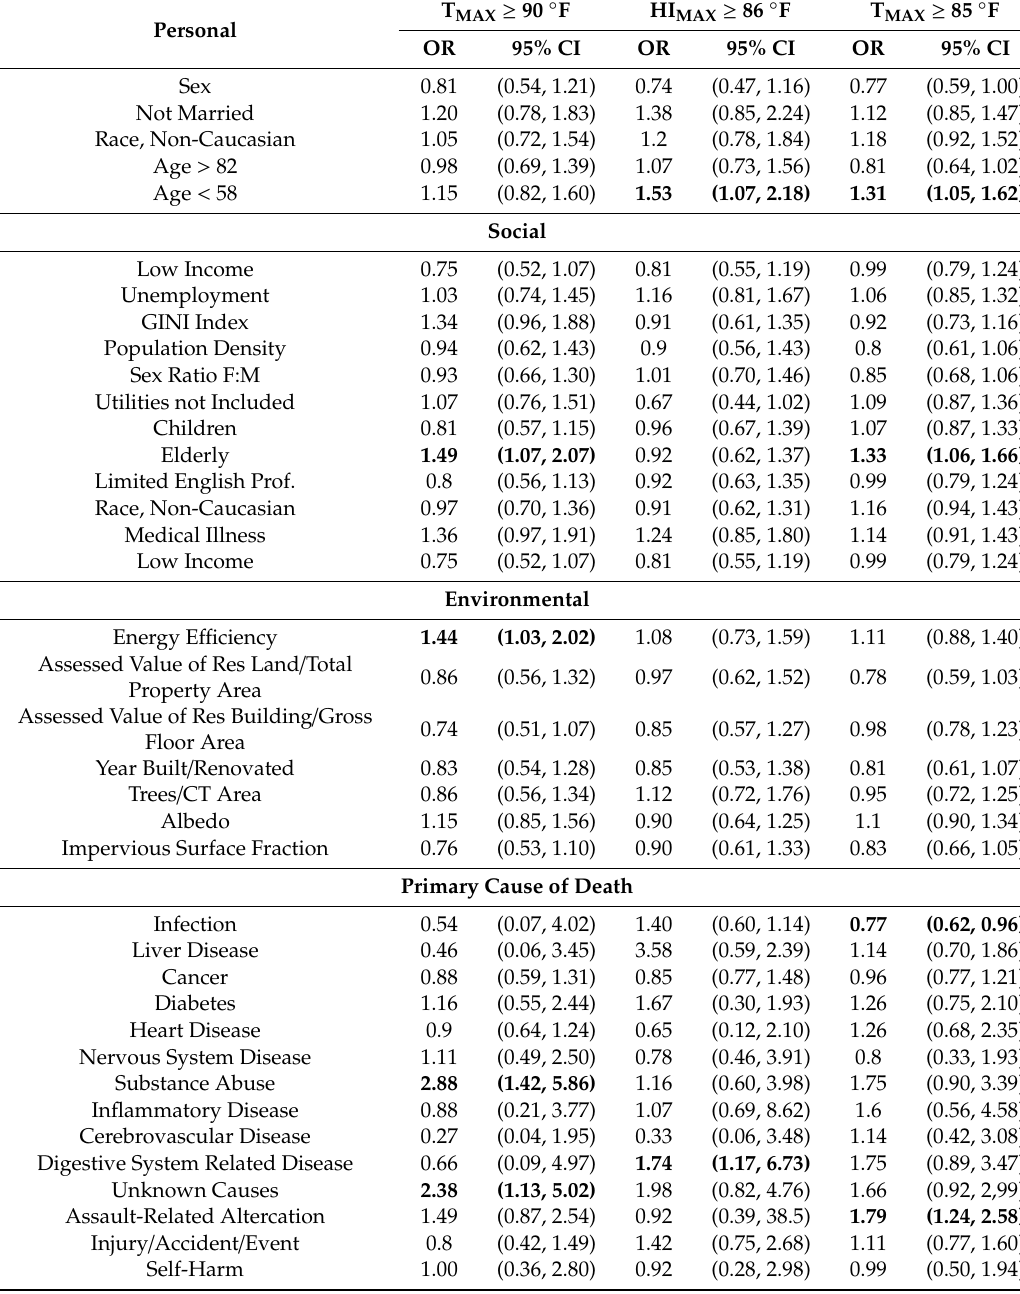
Table 4. The relative odds ratio (OR) of Boston residents dying outside of the home during extreme heat, during the warm season, for those who had the following characteristic (Personal, Primary Cause of Death) or who lived in a census tract with the characteristic (Social, Environmental), compared with those who did not have that characteristic, Boston, 2000–2015. Individuals were considered to either have a personal modifier or not, or were dichotomized based on being either below the 25th percentile or above the 75th percentile of the values for neighborhood modifiers across Boston or dying from that specified primary cause of death. Bold indicates that the OR is significant at p <